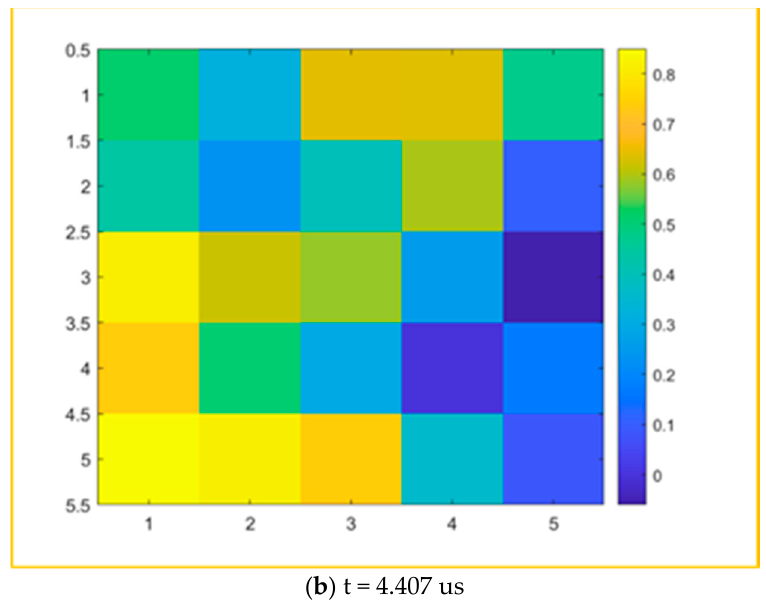
Figure 12. Pattern formation diagrams of the network. They are directly derived from Figure 11. ( a ) is at t = 3.386 us and ( b ) is at t = 4.407 us.